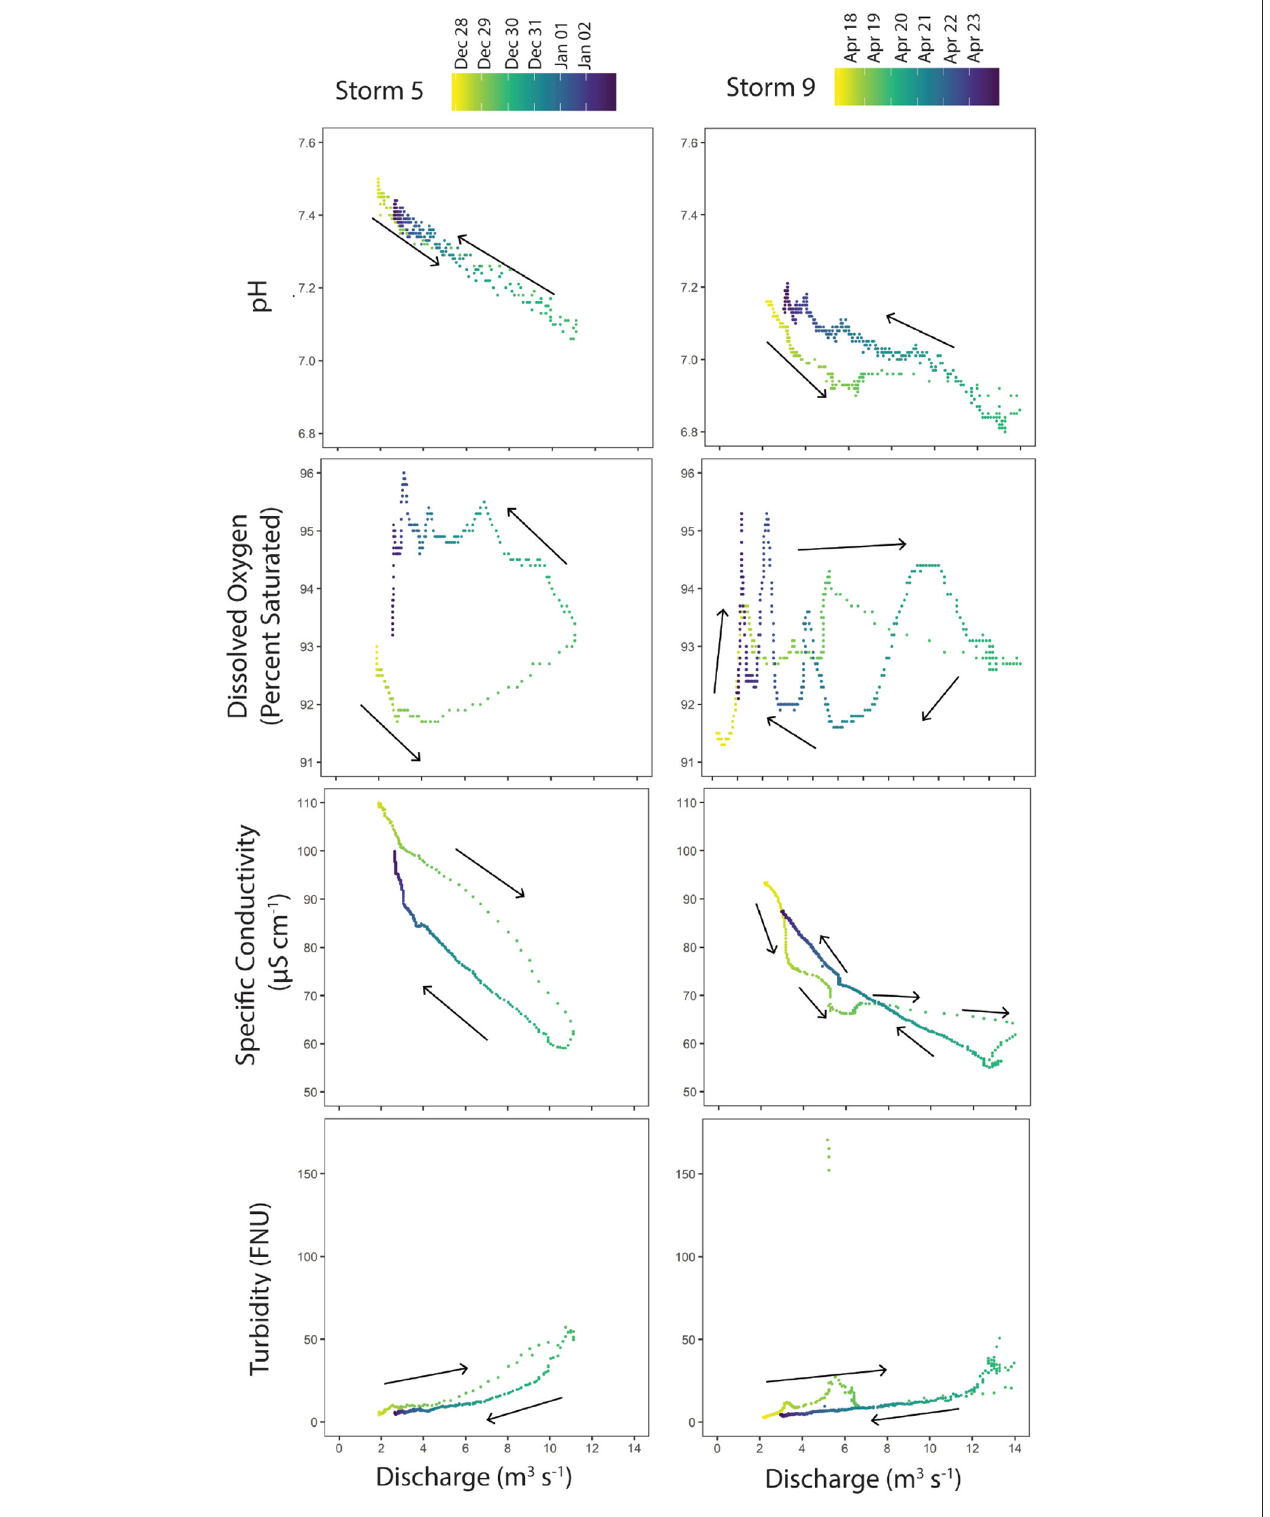
FIGURE 7 | Examples of hysteresis observed for pH, dissolved oxygen, specific conductivity, and turbidity for two storms on the Union River. Two example storms are shown to demonstrate different types of hysteresis seen during the 2017–2018 study.